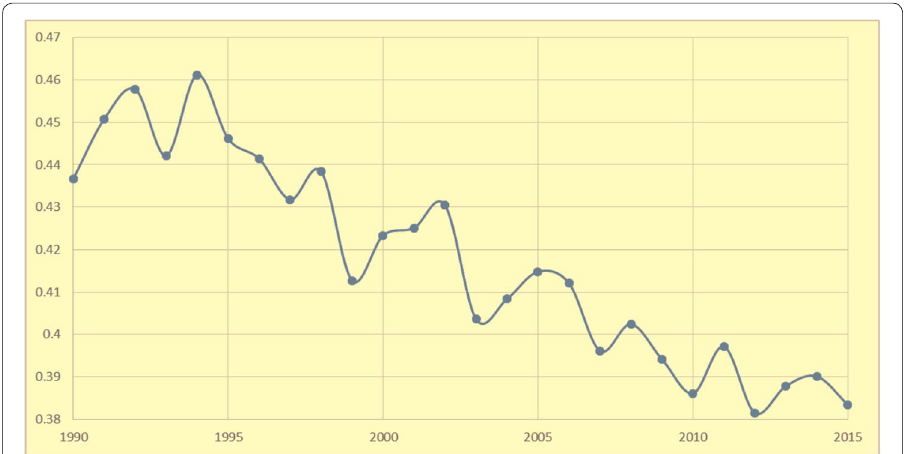
Fig. 1 Movement of income inequality in Turkey,